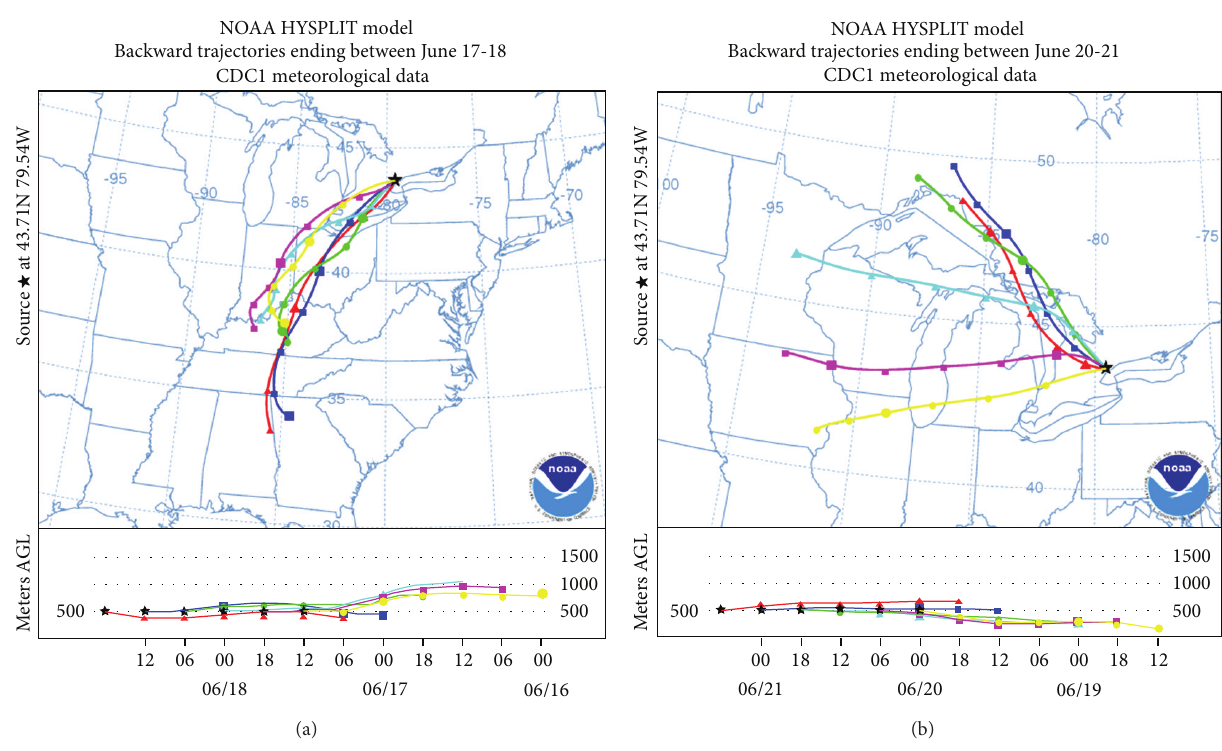
Figure 8: Backward trajectories starting from Toronto in every 6 hours (a) from June 17 at 12:00 UTC to June 18 at 18:00 UTC, and (b) from June 20 at 0:00 UTC to June 21 at 6:00 UTC in 2006. Every trajectory was run for 36 hours. The upper panels show horizontal movements while the lower panels show vertical movements, in which the unit for 𝑦 -axis is meter above the ground level